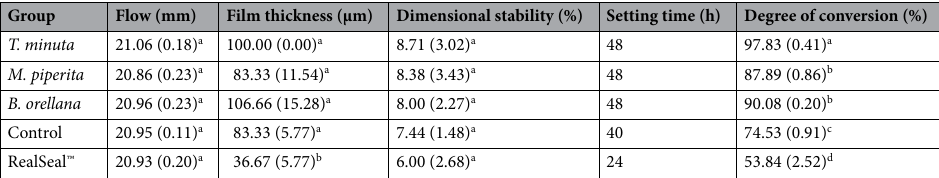
Table 4. Physicochemical and mechanical properties evaluated in different experimental endodontic sealers. Common corresponding letters (a–d) in a given column indicate no significant difference (p < 0.05).